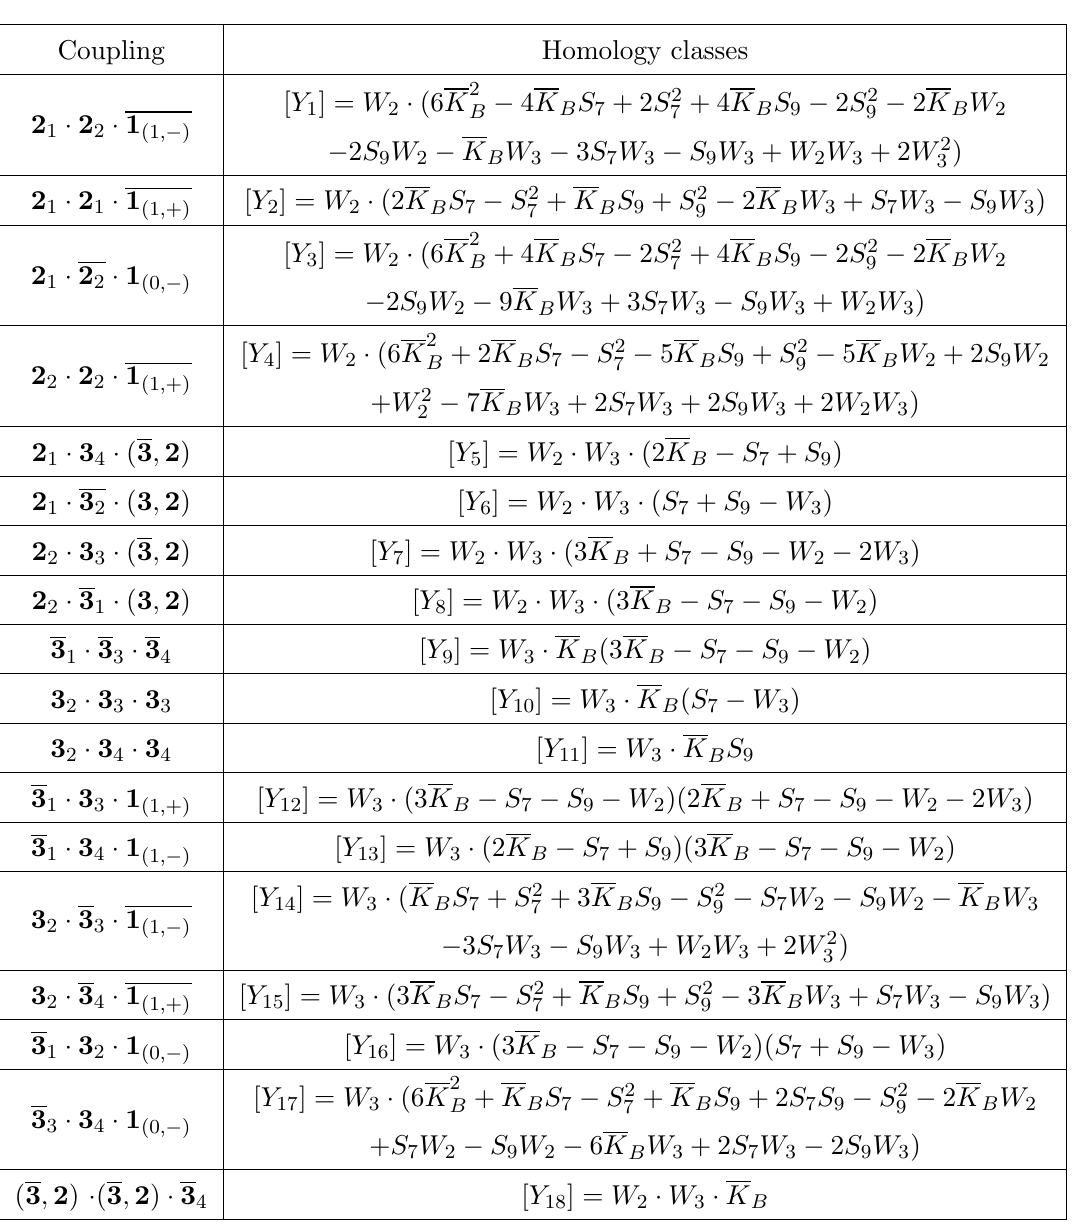
Table 10 . Yukawa points of the (cid:12)rst